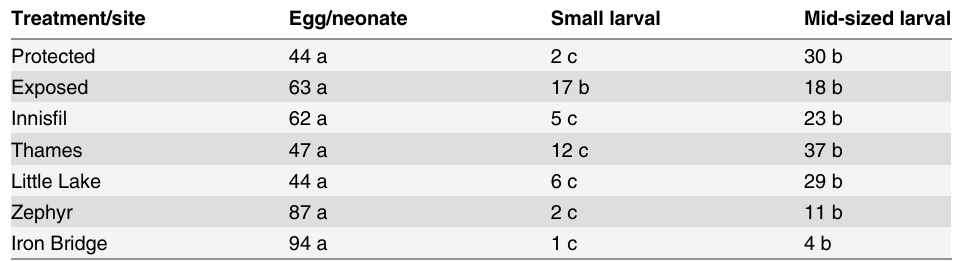
Iron Bridge 94 a 1 c 4 b Different letters indicate statistically signi fi cant differences ( P < 0.05) among life stages according to Tukey ’ s HSD, tested separately for each row, using generalized linear